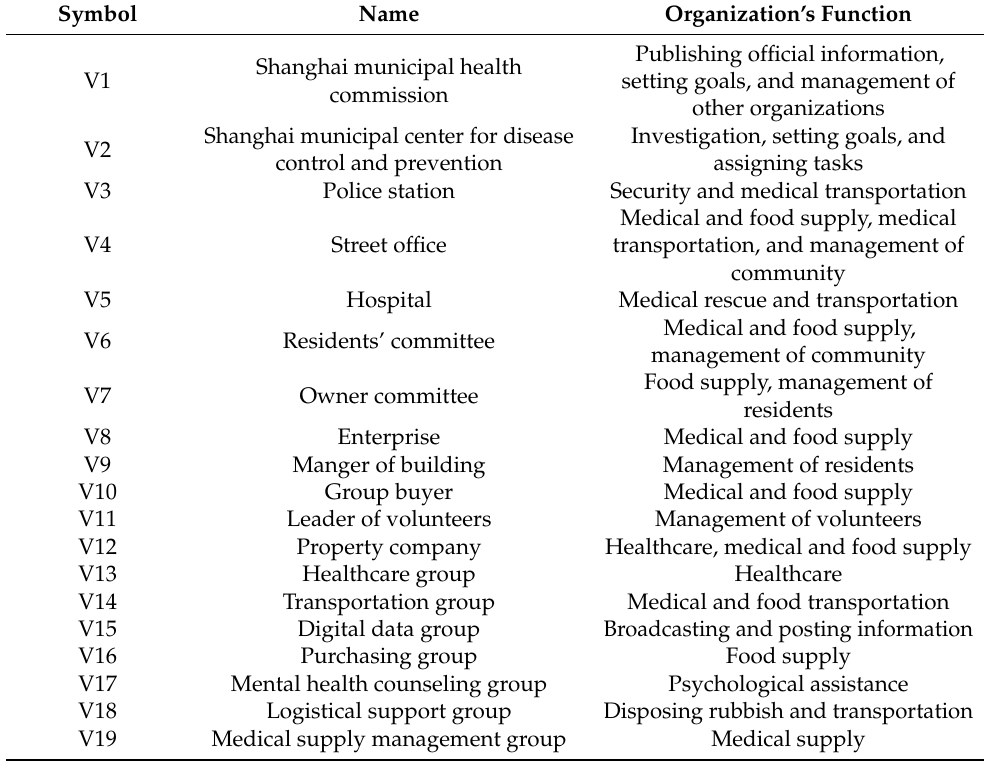
Table 1. Description of organizations in the